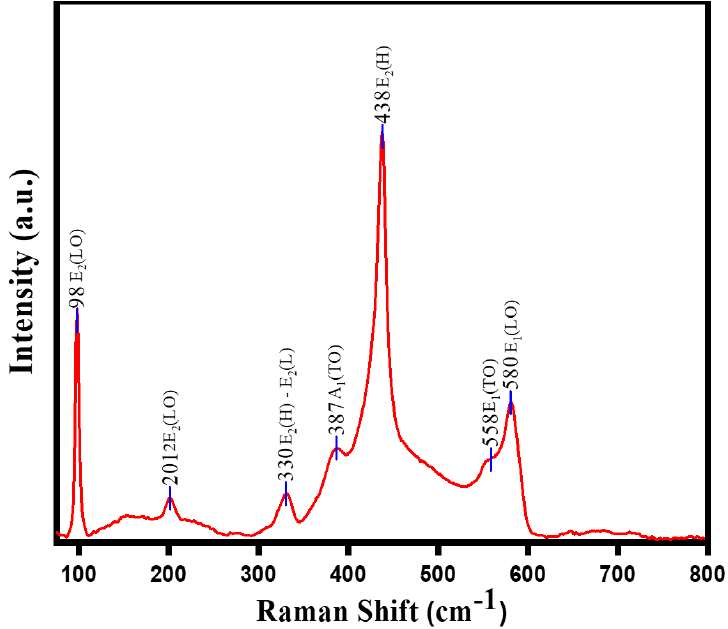
Figure 7. Raman spectra of LP-ZnO NPs. The N 2 adsorption/desorption isotherm plot of LP-ZnO NPs is depicted in Figure 8a. teresis loop; the P/Po numerical values were found to be within the range of 0.8–0.95, corresponding to the presence of mesoporous texture of biosynthesized LP-ZnO NPs with slit-like pores. The observed loops were prominent at relatively higher pressure, which